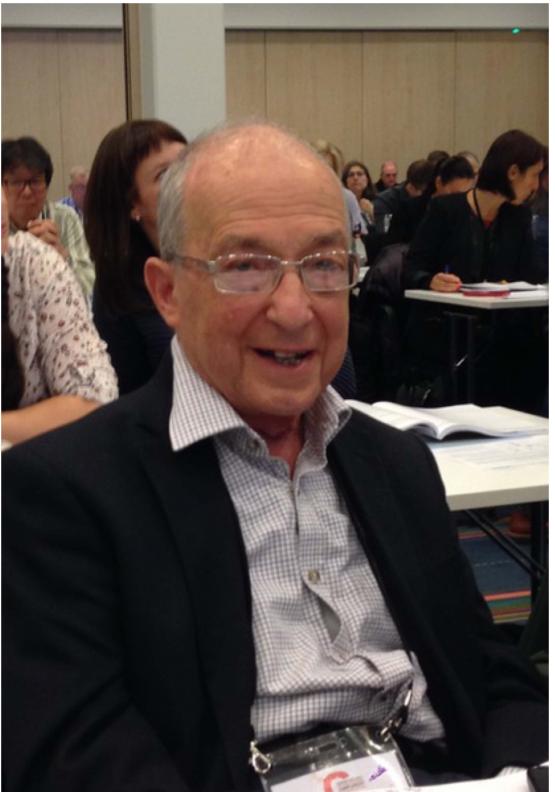
Figure 1. Sir Peter J. Lachmann at the European Complement Network (ECN) meeting, in Copen- hagen, Denmark, 11 September 2017. Peter Lachmann was the recipient of ECN Gold Medal. Photo by Seppo